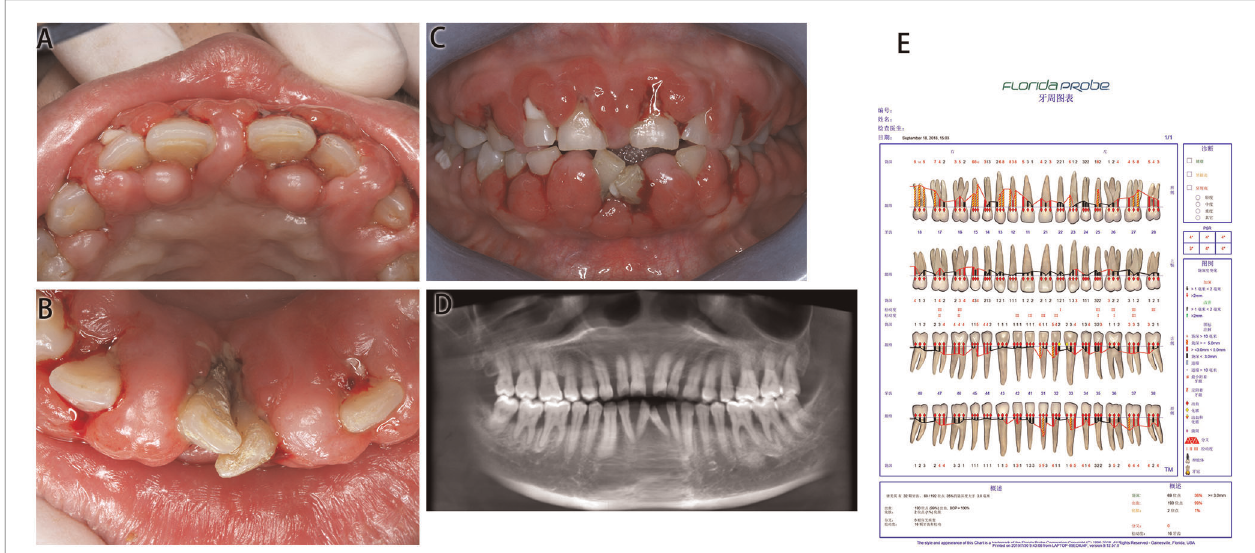
FIGURE 2 | Medical information on Case 2 at fi rst diagnosis (before treatment). ( A ) Maxillary view. ( B ) Mandibular view. ( C ) Frontal view images. ( D ) Radiological images. ( E ) Periodontal examination